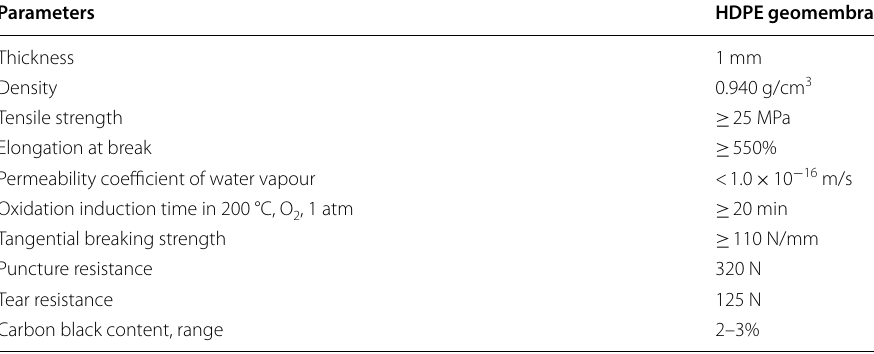
Table 1 Specifications of HDPE geomembrane in landfill